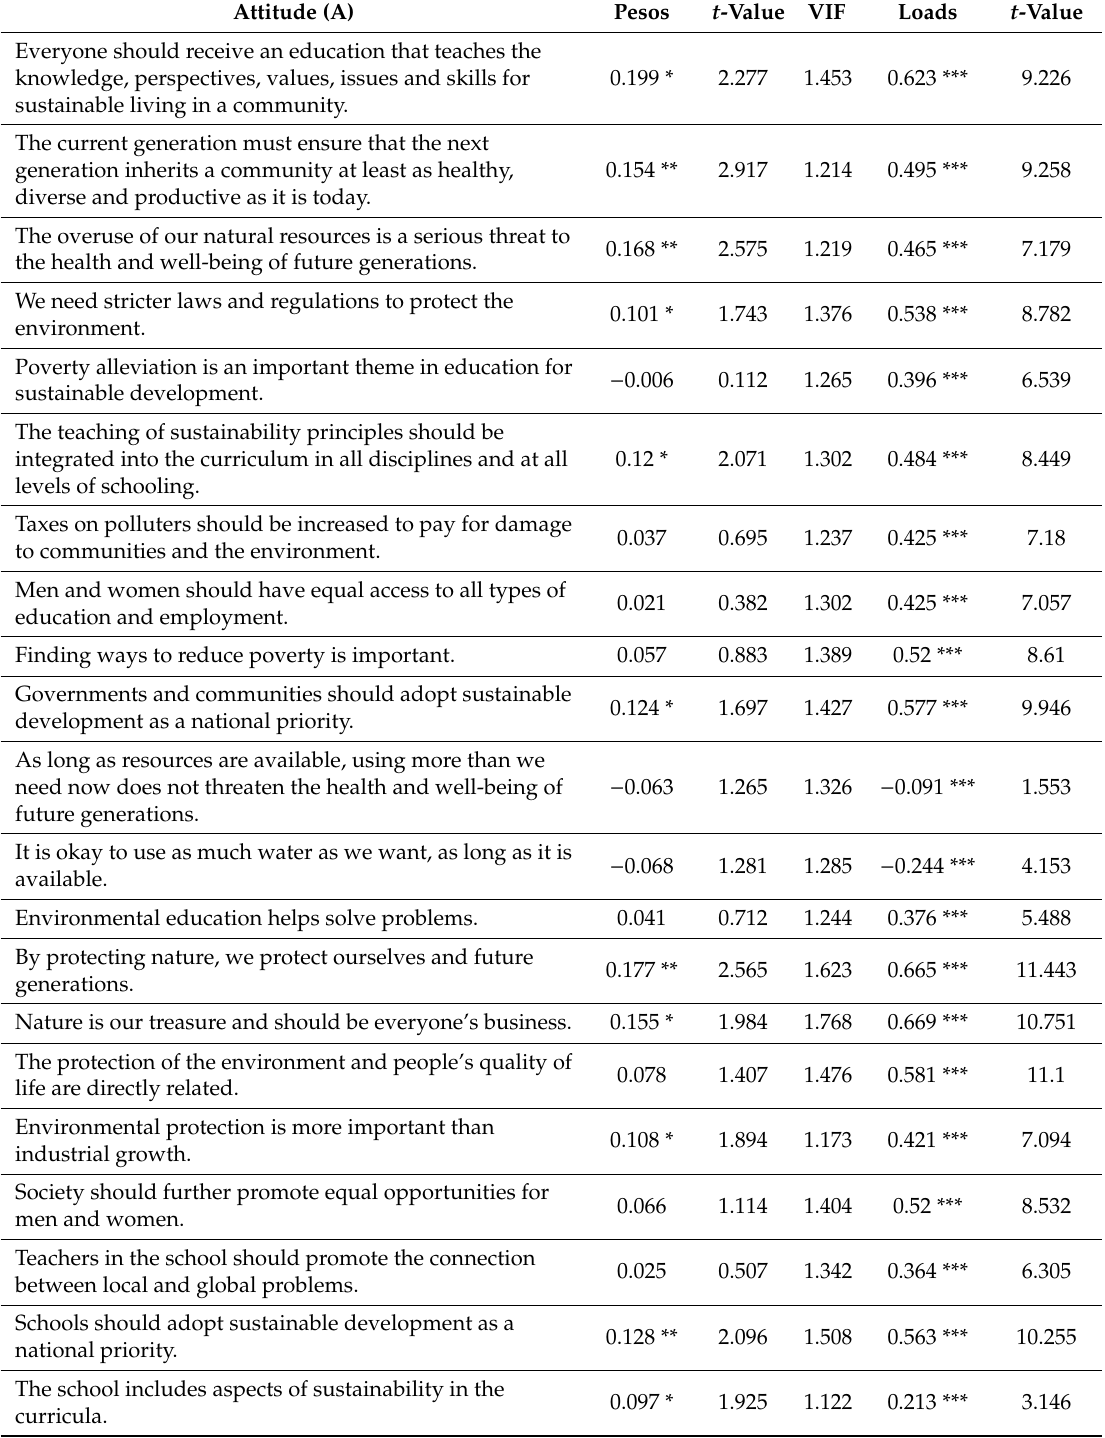
Table 3. Validity and reliability of the measurement model. Composite Mode B. Attitude (A) Pesos t -Value VIF Loads t